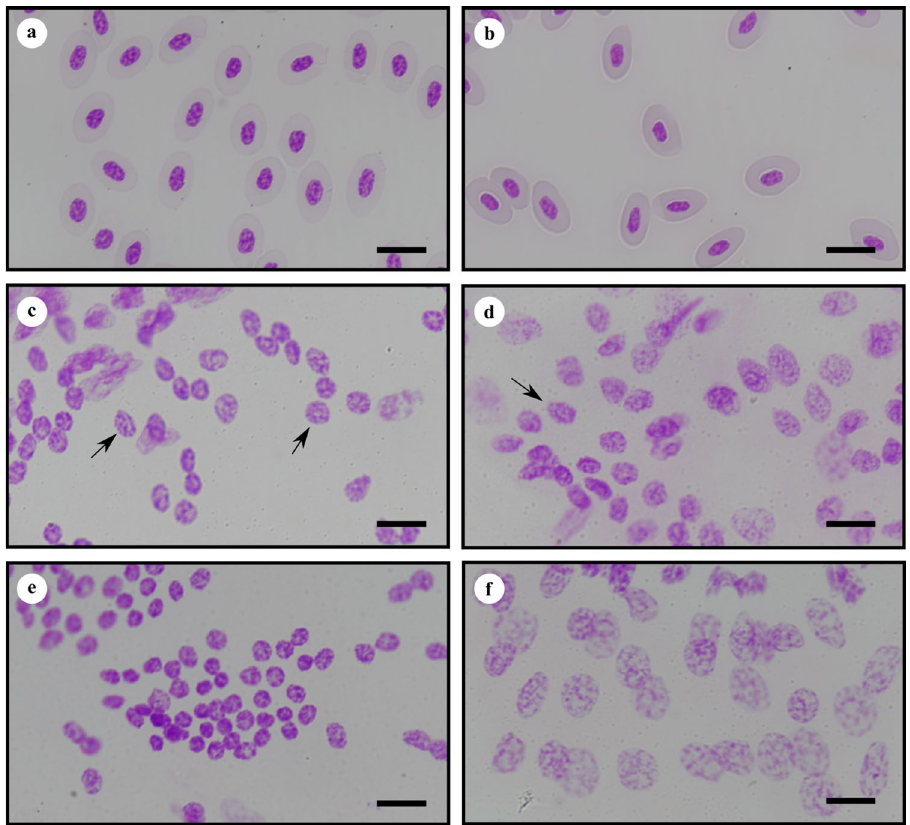
Figure 2. Photomicrographs of squash preparations of somatic nuclei of cephalothorax of L. salmonis salmonis and erythrocytes of hen and trout used as standards, stained with Feulgen reaction for DNA. ( a ) Nuclei of erythrocytes of G. domesticus ; ( b ) nuclei of erythrocytes of O. mykiss ; ( c ) representative nuclei, indicated by arrows, of male L. salmonis salmonis slide 64 whose measurements are given in Table 4; ( d ) representative nucleus, indicated by arrow, of female L. salmonis salmonis slide 63 whose measurements are given in in Table 4; ( e ) nuclei of male L. salmonis salmonis slide 64 with high level of DNA compaction; ( f ) nuclei of male L. salmonis salmonis slide 64 with highly diffuse morphology. Scale bars represent 10